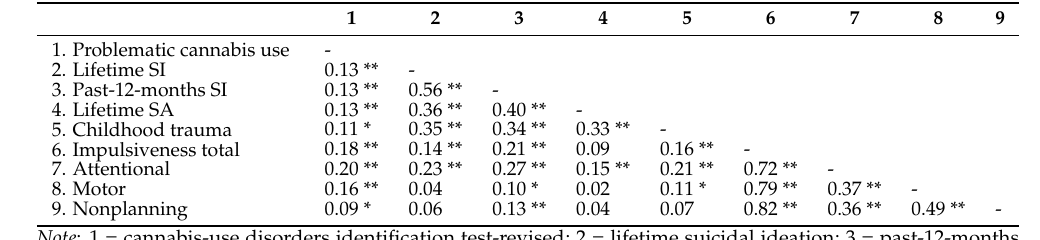
Table 1. Pearson correlations among problematic cannabis use, suicidal ideation and attempt, child- hood trauma, and impulsiveness.